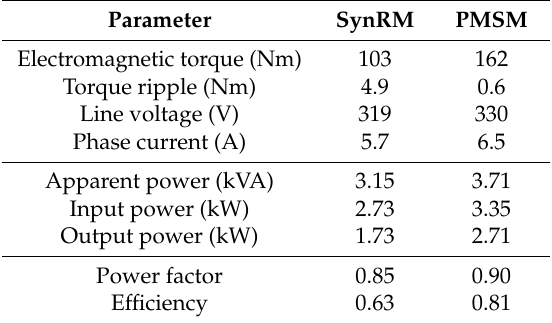
Table 7. SynRM and permanent magnet synchronous machines (PMSM) characteristics for the same volume.